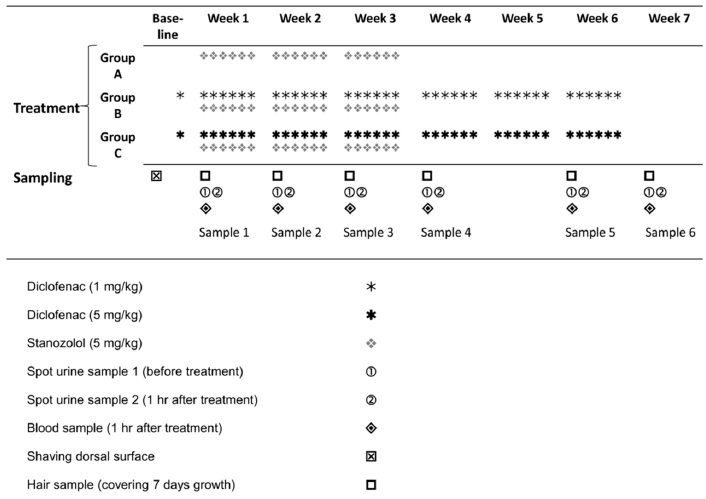
Figure 1. Drug treatment and sample collection period.